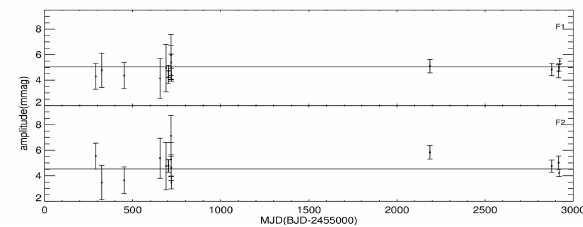
Figure 4. Seasonal amplitude variation and O-C analysis of 2010- 2017 dataset for F1 (top) and F2 (bottom) pulsations.